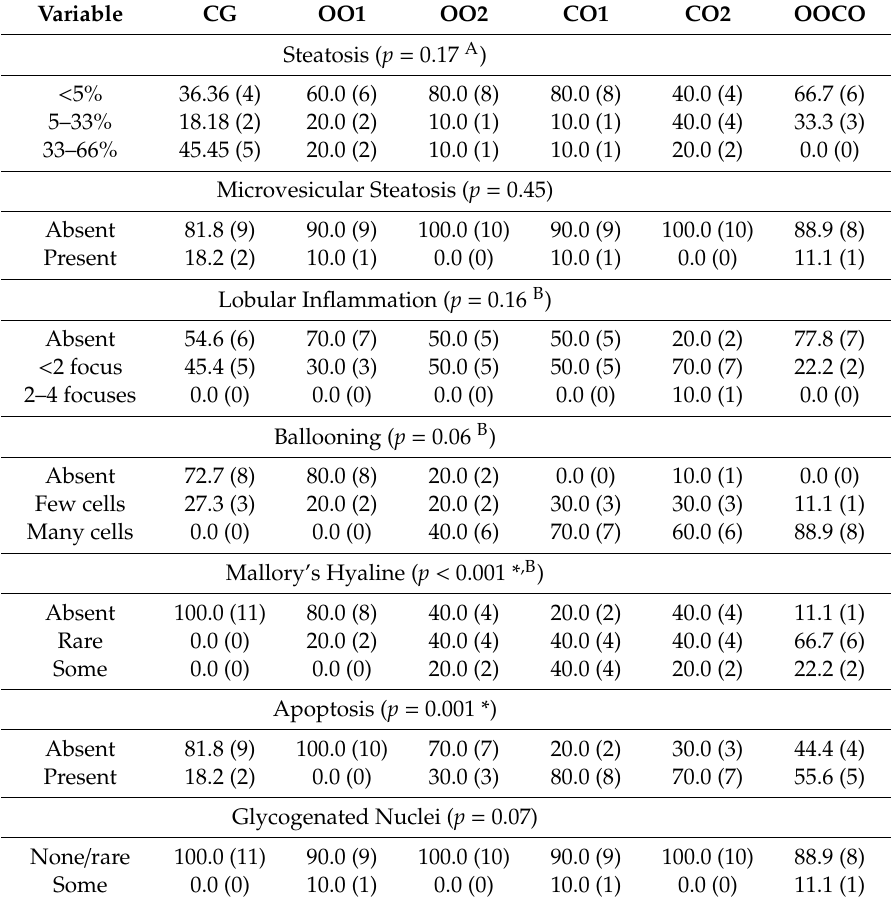
Table 5. Distribution of changes observed in the liver of the animals in the experimental